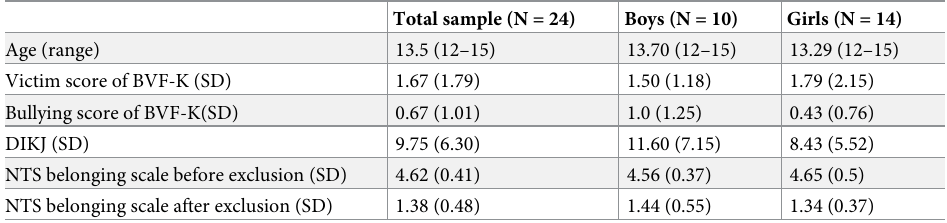
Table 1. Demographic data and descriptive statics of